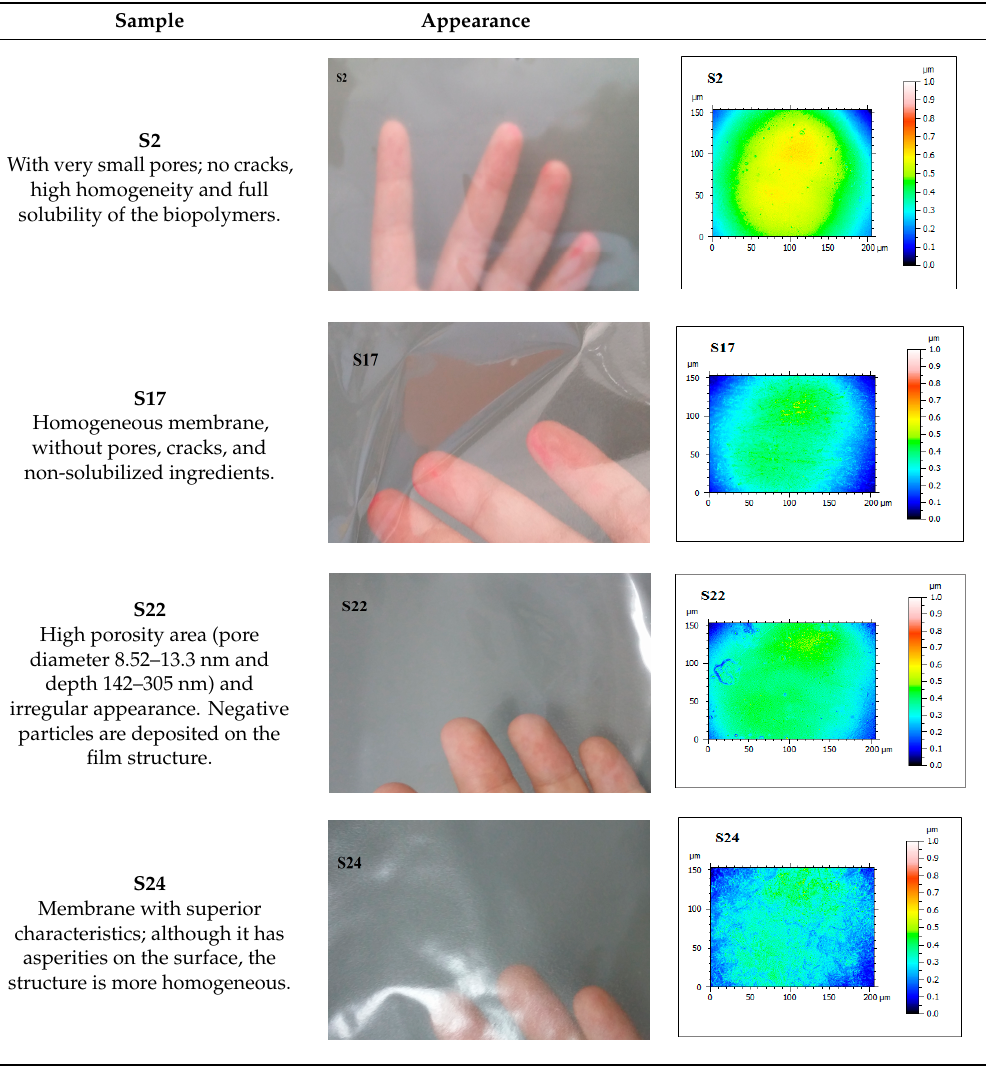
Table 3. Images and microstructures of materials suitable for use as food packaging.